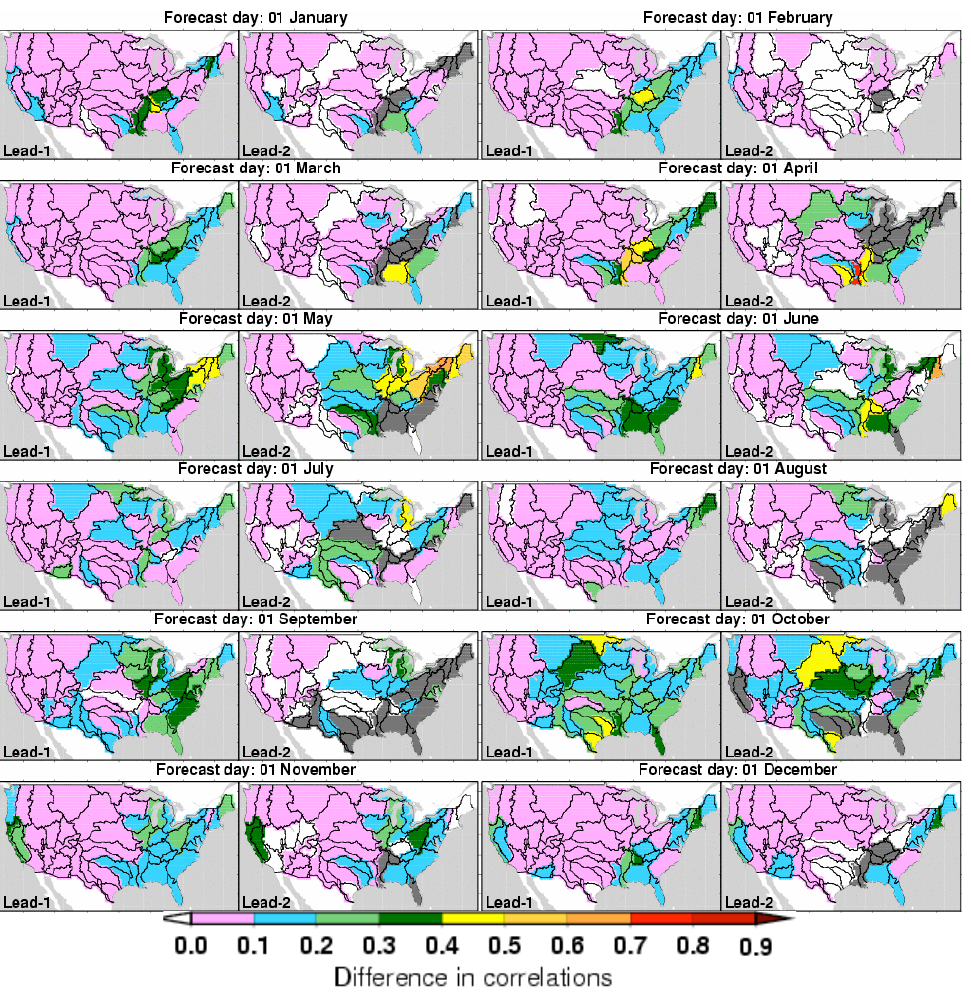
Fig. 8. Potential improvement in SM forecast skills at leads 1–2 months (dark grey color shows where the skill of OBS Merged ESP is not Figure 8: Potential improvement in SM forecast skills at leads 1-2 months. (Dark grey 3 significant at the 95% significance color shows the skill of OBS_Merged_ESP is not significant at 95% significance level.) 4